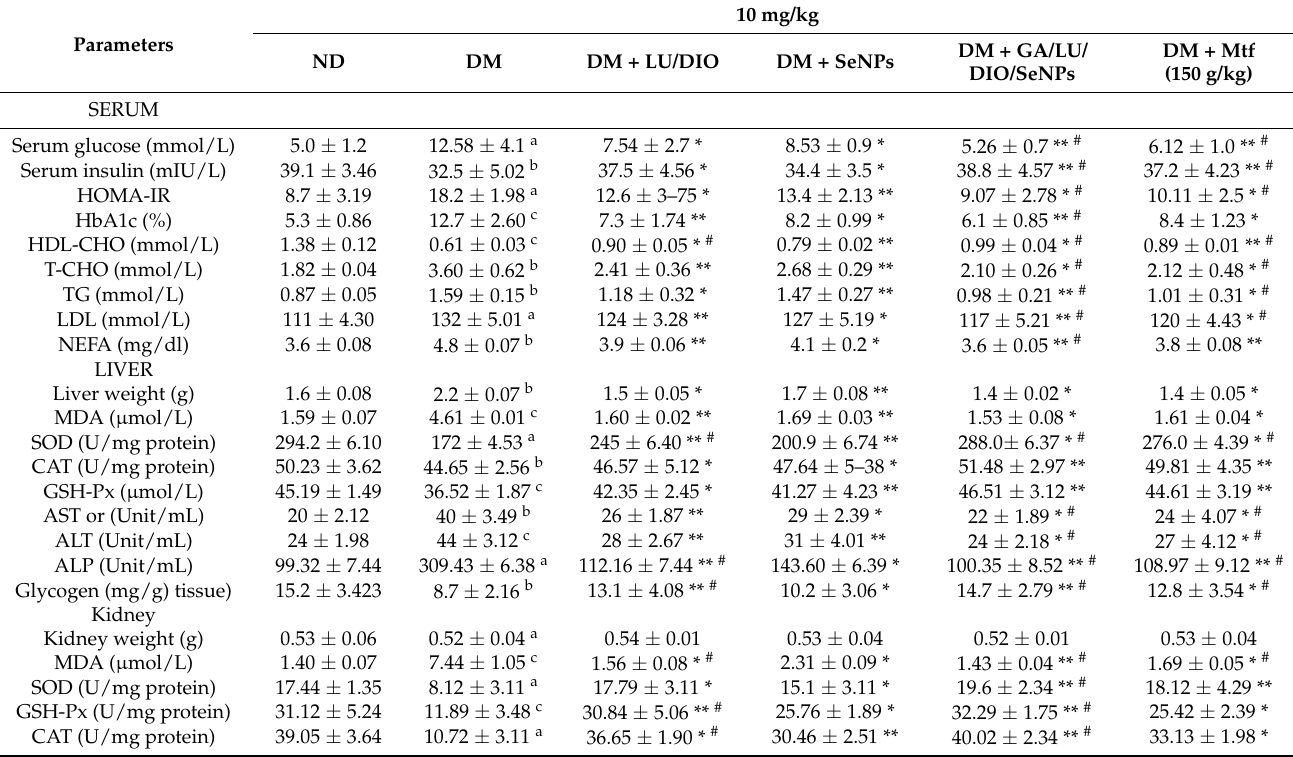
Table 6. Effect of flavonoid formulation LU/DIO, SeNPs, and GA/LU/DIO-SeNPs on different serum, hepatic, and pancreatic markers in STZ-induced diabetic